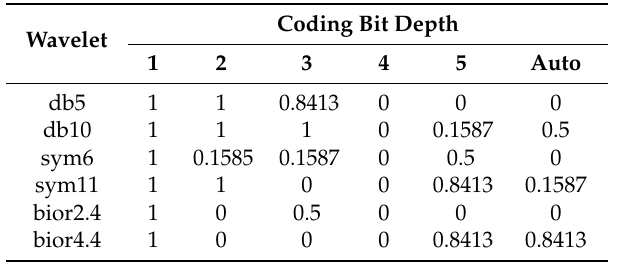
Table 4. T -test value (confidence level p = 0.05) of pairwise comparisons of 100-elements error sets between numerical and textual watermark contents; the interval measured was QRS